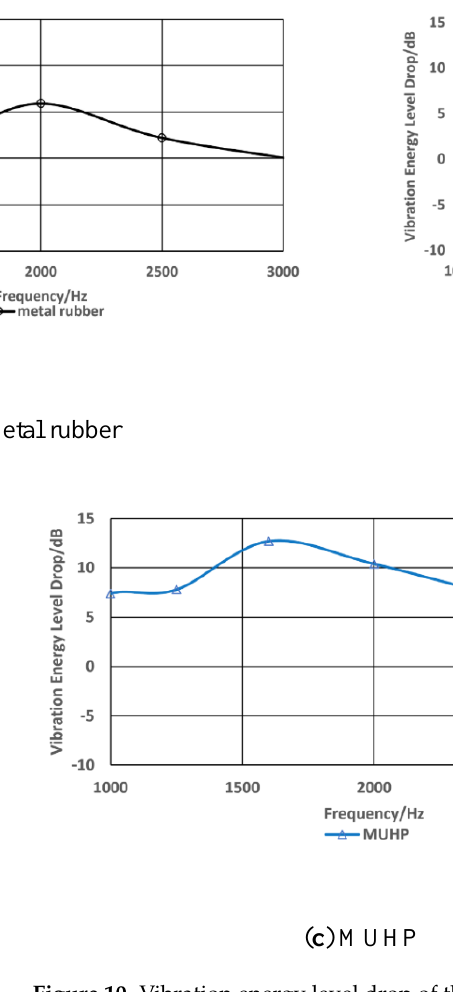
Figure 10. Vibration energy level drop of the three new isolators.